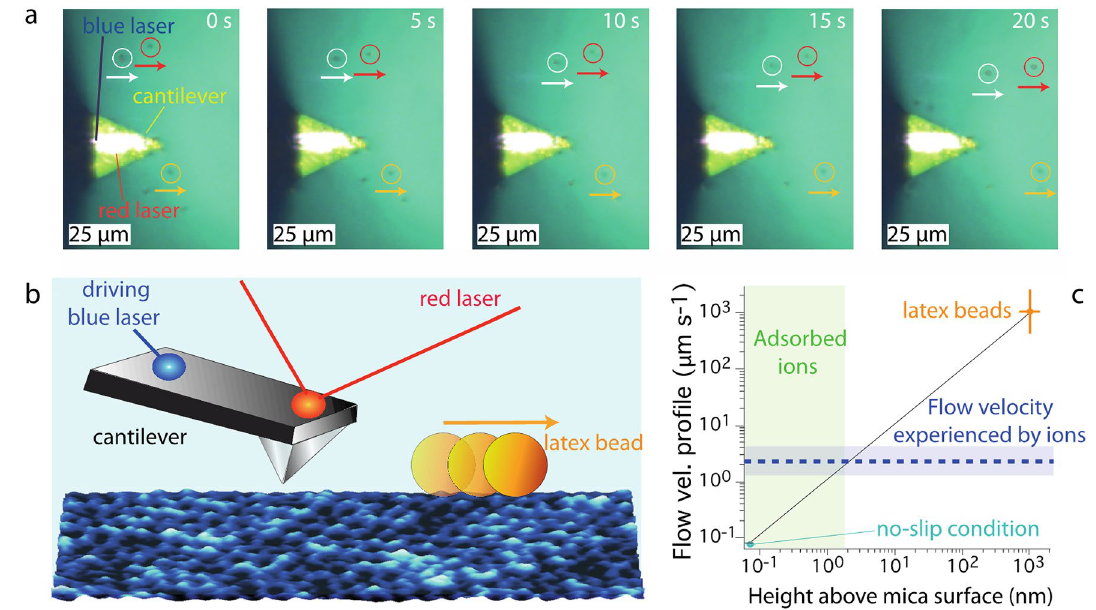
Figure 2. Shear flow analysis. ( a ) Representative time-lapse optical microscopy images of latex beads moving away from the AFM cantilever. The latex beads are highlighted by yellow, white and red circles. ( b ) Schematics highlighting the key events at the water-mica interface. The cantilever is photothermally excited by a blue laser focused near its base. The red laser deflection is used to track the cantilever motion. The periodic motion of the cantilever driven by the blue laser combined with the heat transferred to the fluid by the blue laser itself generate a thermal gradient responsible for the shear flow the latex beads experience. The orientation of the shear flow with respect to the cantilever is the same as in Fig. 1. ( c ) Assuming a no-slip boundary condition for the water-mica interface 7,65 , the fluid velocity profile for the adsorbed ions can be inferred from the measured latex bead velocity profile (~ 3 μm/s). The motion of the latex beads was calculated assuming a distance from the surface equal to the radius of the particles (focus point of the microscope). The value and associated error in ( c ) represent the average and standard error from three independent experiments performed using different cantilevers, solutions, and mica substrates. All the experiments were performed at thermal equilibrium (25.0 ± 0.1 °C), based on a constant heating/cooling rate of the AFM temperature control system. Within each experiment, at least three sets of data tracking the dynamics of the latex beads were captured and analysed. The results confirmed reproducibility and consistency of the shear flow with minimal fluctuations when operating at thermal